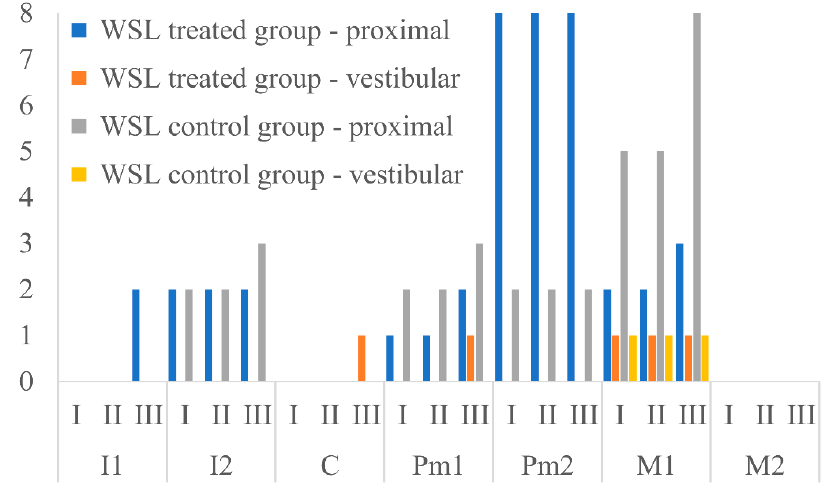
Figure 2. Presence of enamel decalcification (ICDAS 1–2) during 6 month follow-up in patients from both groups. I, incisors; C, canines; Pm, premolars, M, molars.